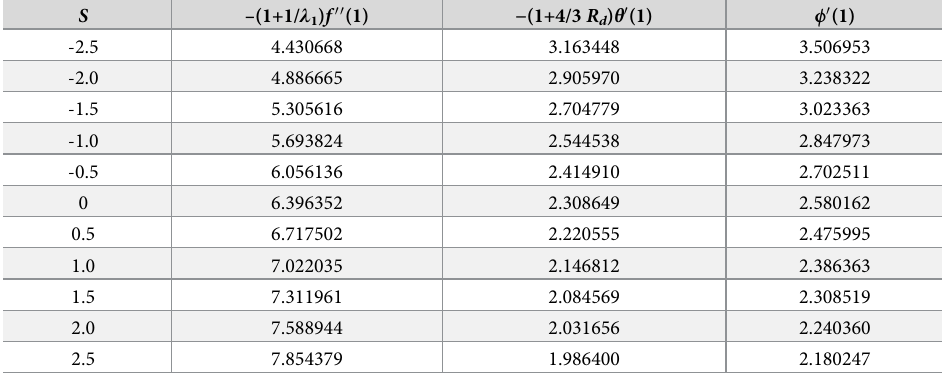
Table 4. Numerical results of –(1+1/ λ 1 ) f 00 (1), − θ 0 (1) and ϕ 0 (1) for S as γ = De = 0.01, Ec = Ha = R d = N b = N t = 0.1, λ 1 = Da = δ = 1 and Le = R = Pr =